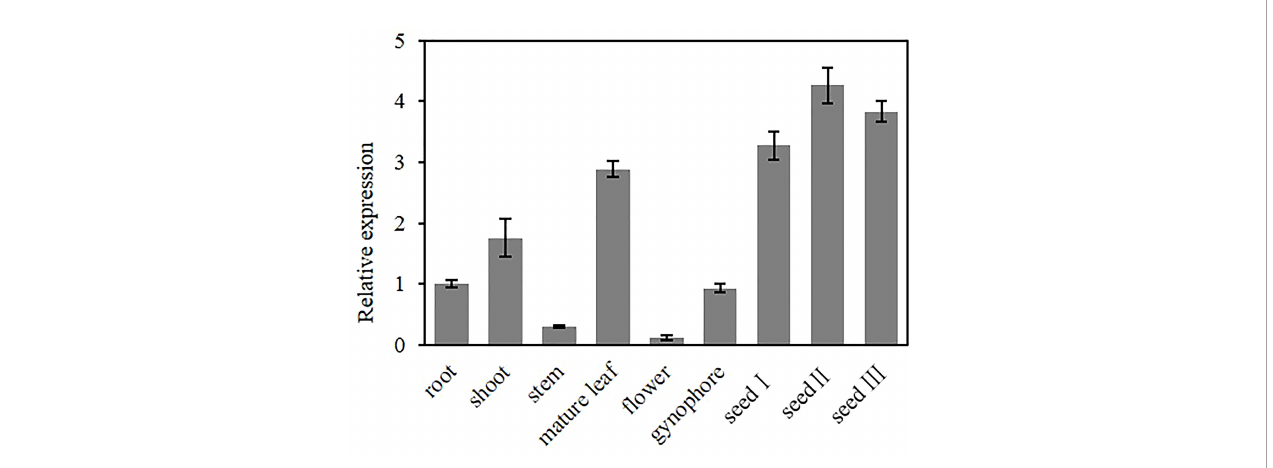
(Figure 6B). The content of 16C/18C/20C/22C FAs were then summed separately, and it was found that the content of 16C FAs in overexpression lines signi fi cantly reduced, while the content of 18C FAs signi fi cantly increased (Figure 6C). Similarly, the content of monounsaturated FAs signi fi cantly decreased and the content of triunsaturated FAs signi fi cantly increased in overexpression lines, while the content of saturated FAs remained stable (Figure 6D). These results indicate that overexpressed AhGPAT9 not only signi fi cantly increases the oil content of transgenic seeds, but also signi fi cantly changes their FA composition ratio, suggesting that it may be preferable to utilize linolenic acid and eicosatrienoic acid as substrates during TAG assembly.